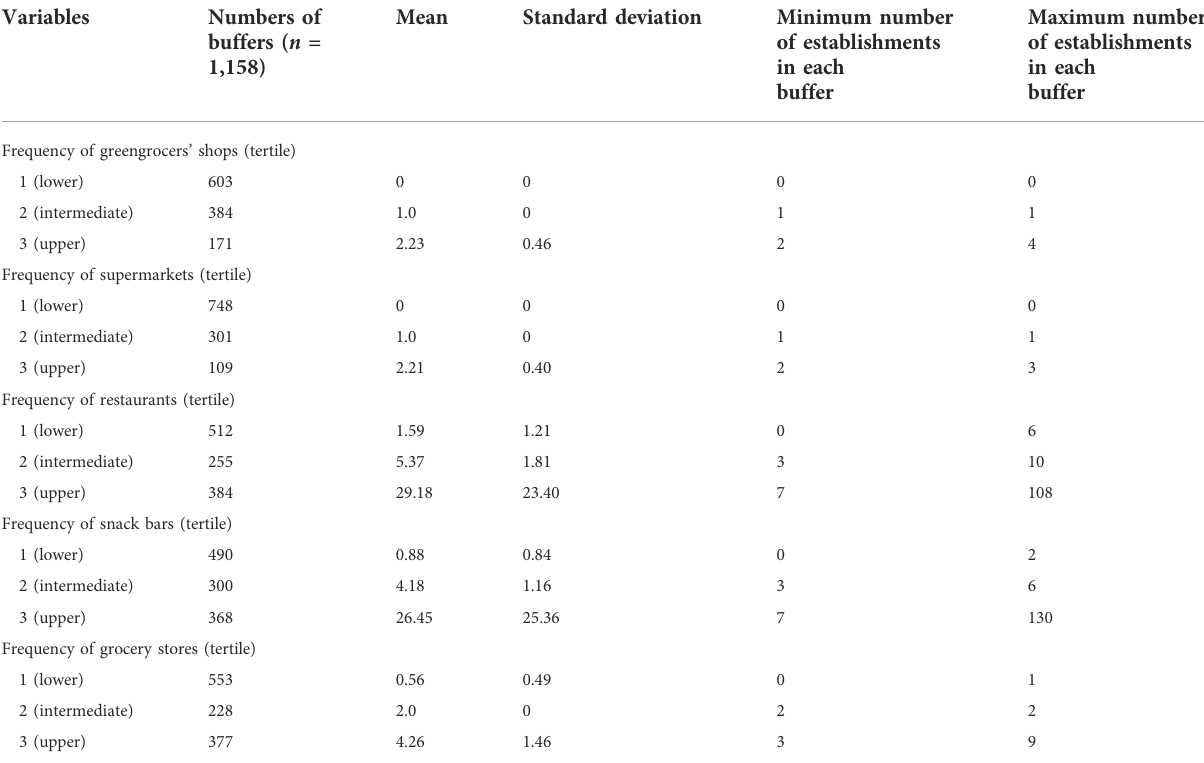
TABLE 2 Descriptive analysis of variables of the food environment in buffers around the residence of older adults of the Epi fl oripa Aging Cohort Study-Wave 2, Florianópolis, SC, 2013-2014.